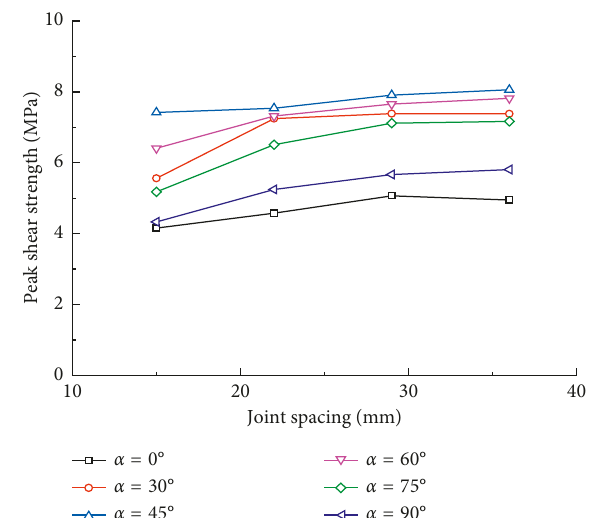
Figure 8: Effect of the joint spacing on the peak shear